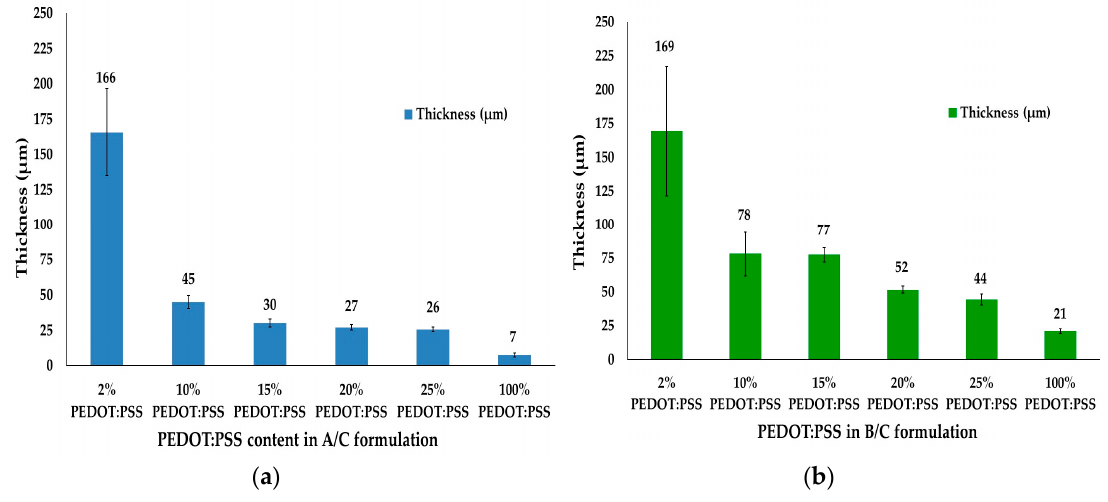
Figure 2. Conductive dry films (tracks) thicknesses ranging for different content of polymer complex PEDOT:PSS in aqueous conductive dispersion: ( a ) A/C formulation, ( b ) B/C formulation.